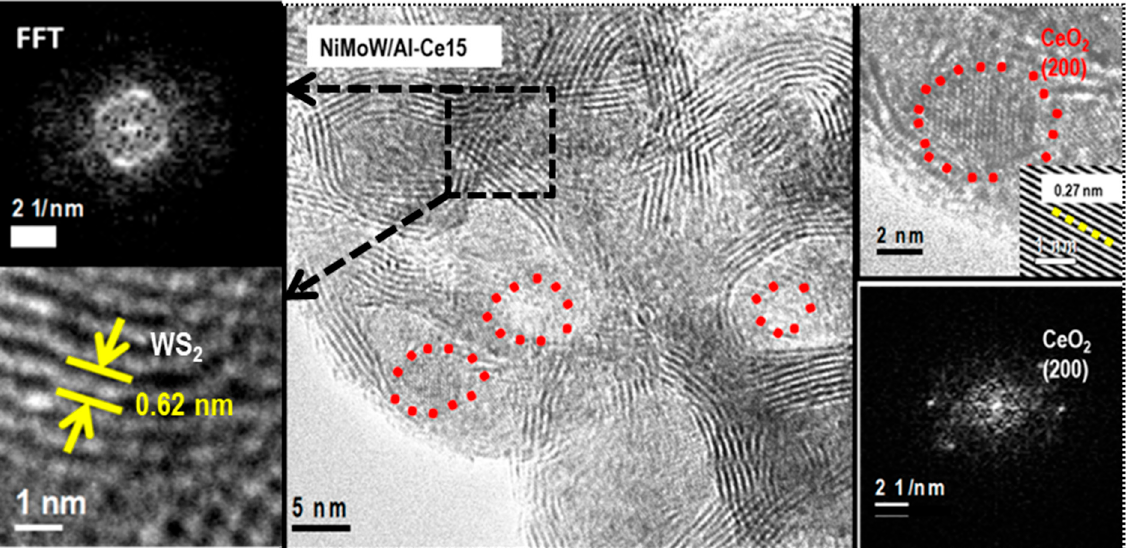
Figure 12. HRTEM image of the used NiMoW/Al ‐ Ce15 catalyst showing the CeO 2 (red circle) and Mo(W) 2 (black square) phases. The insets show FFT and IFFT images of the corresponding areas marked in the HRTEM image.